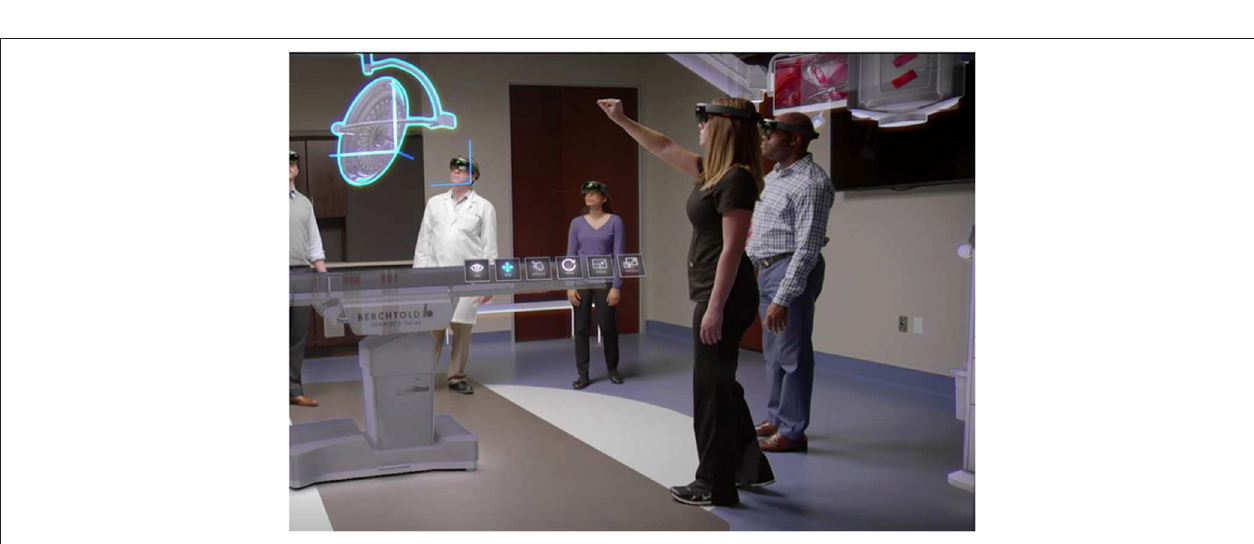
FIGURE 4 | A mixed reality scenario showing a virtual ship merged with the physical environment at Fremantle, Western Australia.